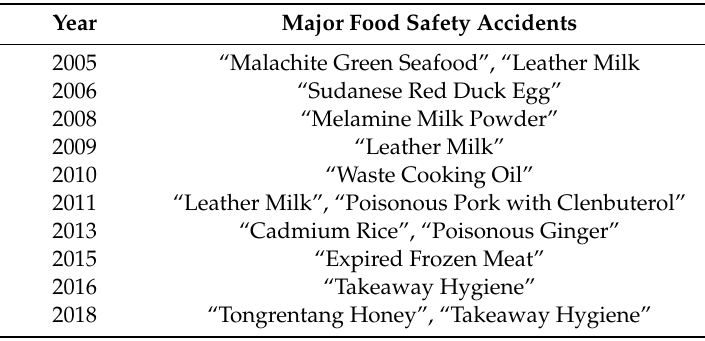
Table 1. Major food safety accidents in recent years in